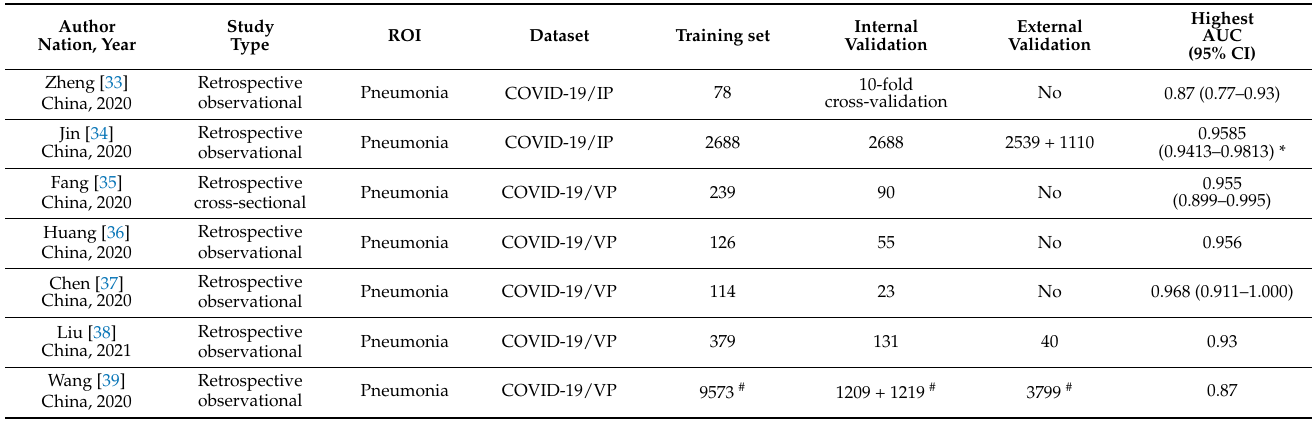
Table 1. Details of the chosen studies.